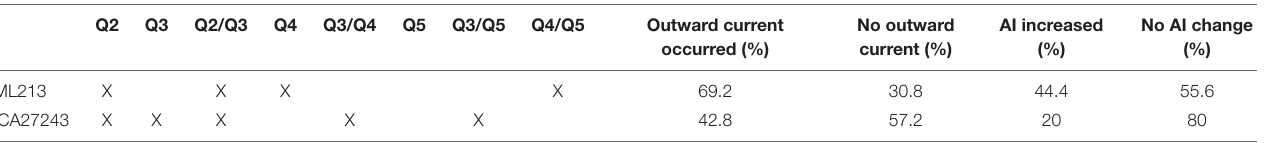
FIGURE 5 | The presence of the KCNQ4 subunit can be detected in a subpopulation of PPN cholinergic neurons. (A) Actions of the nonspecific KCNQ opener retigabine on the M-current ( black : control trace; blue : trace with retigabine). (B) Representative M-current traces under control conditions ( black ) and with the KCNQ2- and KCNQ4-specific opener ML213 ( blue ). (C) Representative M-current traces under control conditions ( black ) and with the KCNQ2- and KCNQ3-specific opener ICA27243 ( blue ). Dashed lines indicate the holding currents in the control. Dotted lines indicate 0 pA. (D) Statistical comparisons of the currents activated by retigabine ( R ), ML213 ( M ), and ICA27243 ( I ) at –20 mV holding potential ( green : outward currents greater than 10 pA; red : currents less than 10 pA; black squares : mean ± SD). With retigabine, the holding current at –20 mV increased from 95.25 ± 11.96 to 140.23 ± 12.24 pA ( n = 11, p = 0.0089). With ML213, the increase of the holding current at –20 mV holding potential was 25.61 ± 5.94 pA (from 143.99 ± 28.00 to 169.61 ± 29.66 pA; n = 13, p = 0.269). With ICA27243, the increase in the outward current was 19.00 ± 8.61 pA (from 165.04 ± 23.23 to 174.96 ± 25.78 pA; n = 7, p = 0.389). (E–G) Representative voltage traces obtained with 100 pA depolarizing current injections under the control conditions ( black ) and with non-selective (retigabine) * p < 0.050. (E) , KCNQ2- and KCNQ4-selective (ML213) (F) , and KCNQ2- and KCNQ3-selective (ICA27243) (G) openers. Dotted lines indicate 0 mV. (H) Statistical comparison of the changes in AI by openers with different selectivities ( green : increase; red : no change or decrease in individual data; black squares : mean ± SD). *** p < 0.001 (significant difference). With retigabine, the AI increased from 0.330 ± 0.035 to 0.755 ± 0.100 ( n = 9, p = 0.0005), with ML213, the AI changed from 0.357 ± 0.066 to 0.608 ± 0.131 ( n = 10, p = 0.067), and with ICA27243, the AI was 0.392 ± 0.025 in the control and 0.439 ± 0.098 after drug application ( n = 10, n.s.). TABLE 2 | Actions of M-current openers on the KCNQ